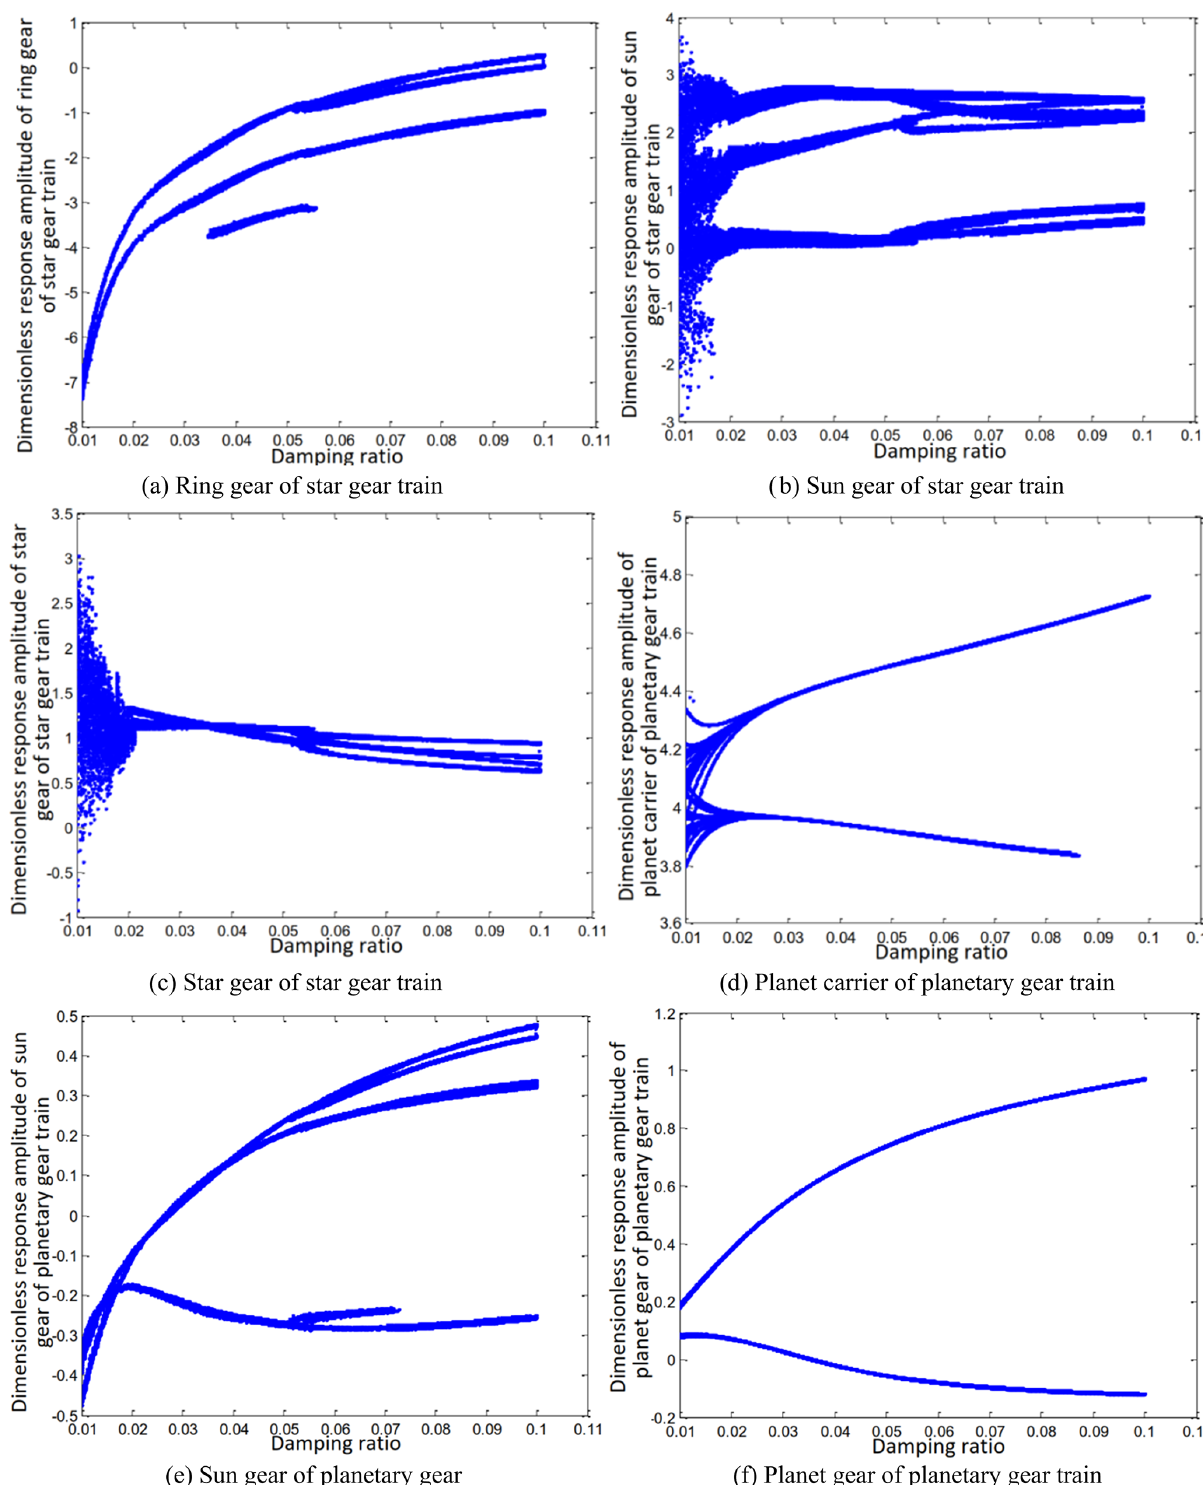
Figure 6. Bifurcation diagram of the variation of damping ratio with the